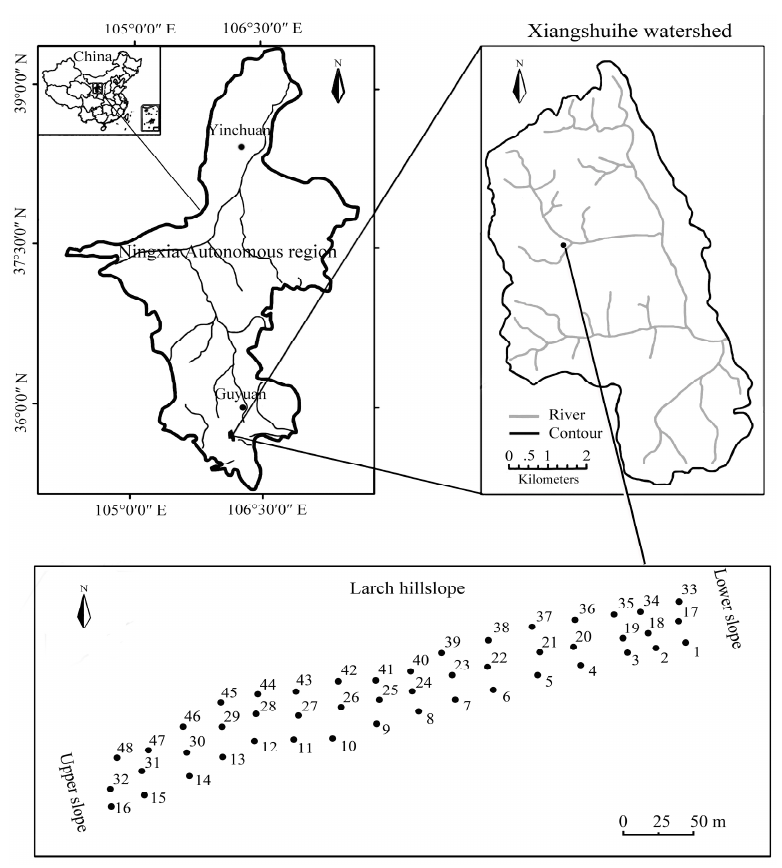
Figure 1. Location of study area and sampling points across the larch plantation on the slope.